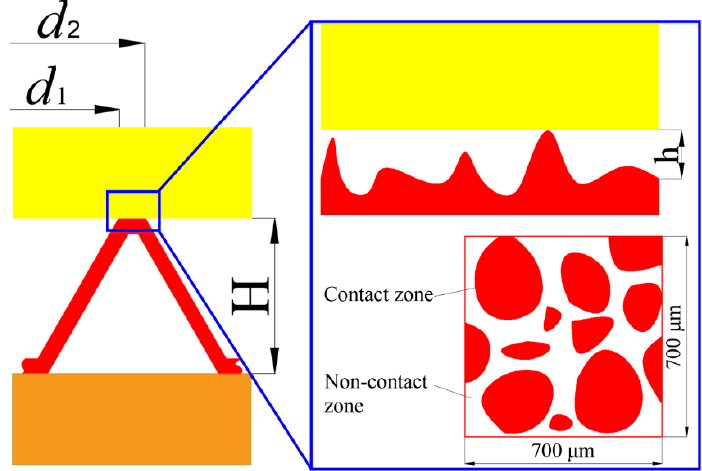
Figure 2. Schematic diagram of the porous interface on real sealing face.